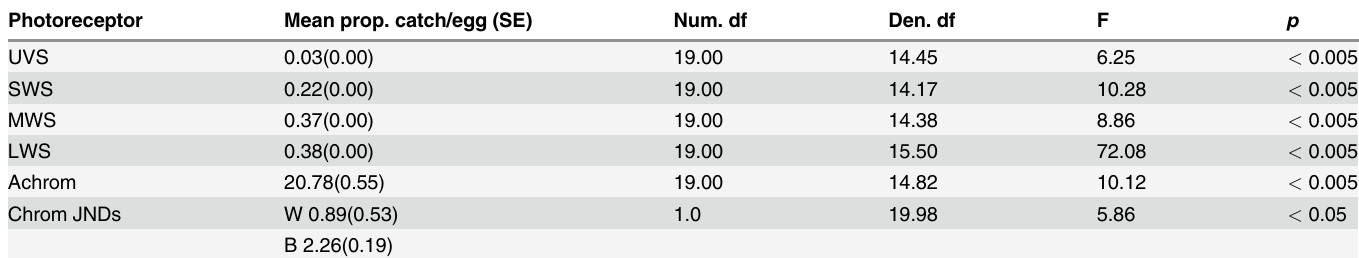
Table 4. Univariate ANOVA